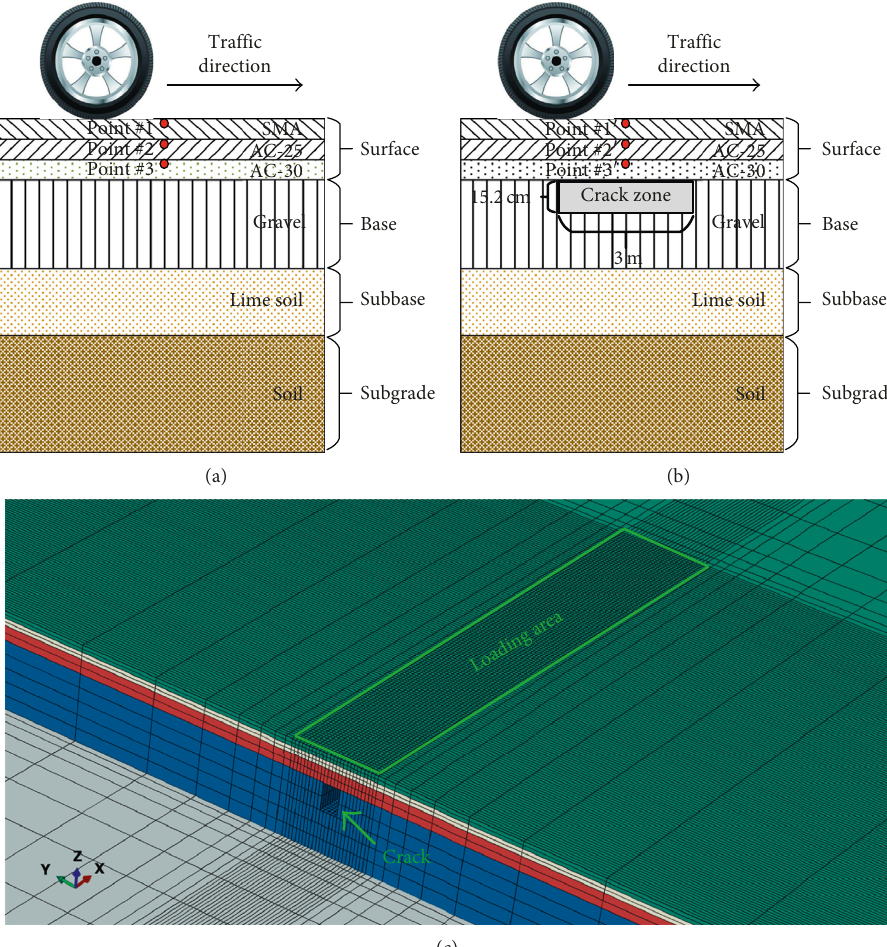
Figure 14: The monitoring points on the longitudinal section below the tire center line. (a) Intact pavement. (b) Damaged pavement. (c) Crack zone and loading